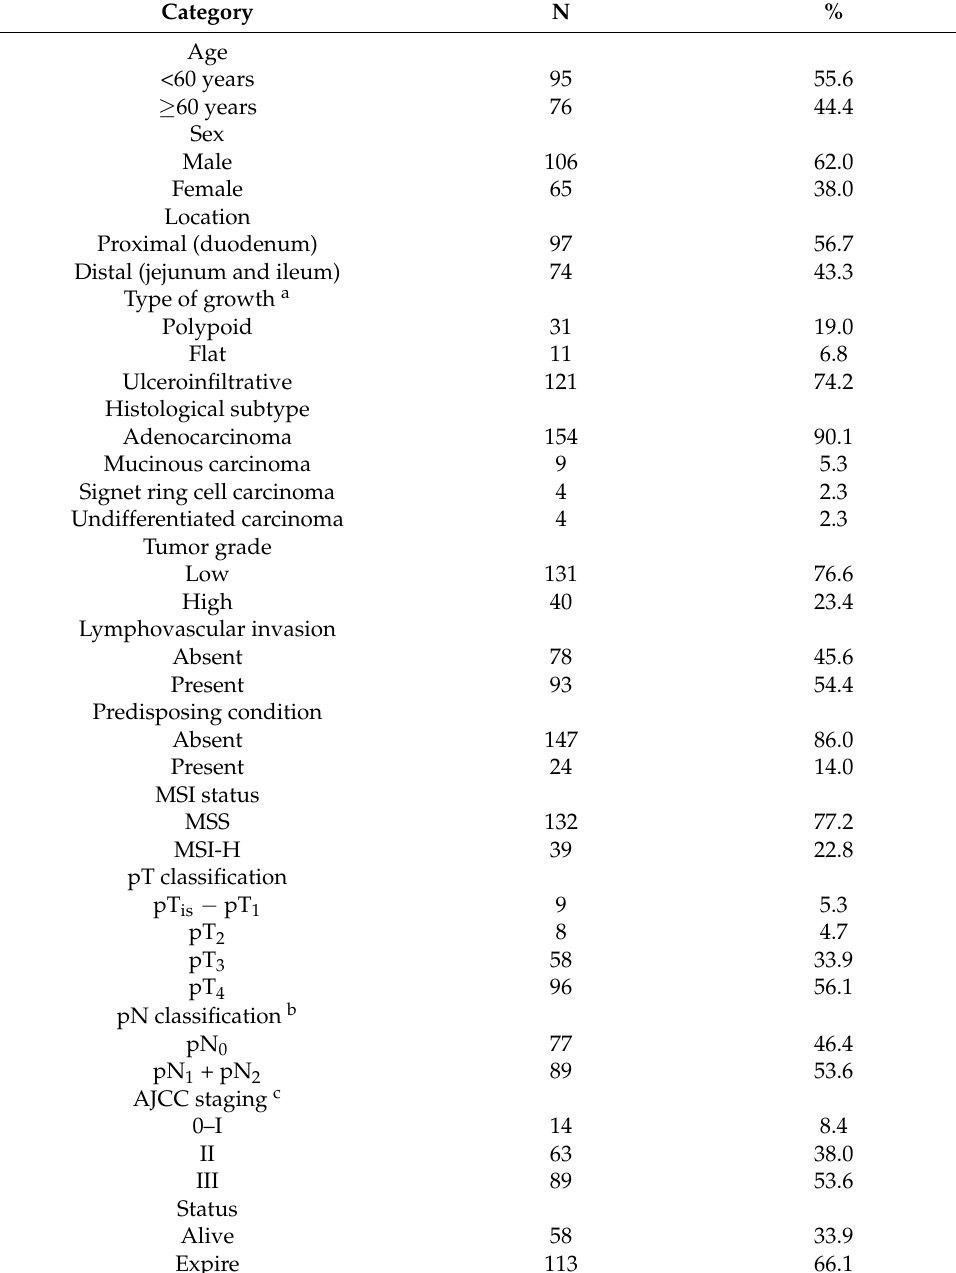
Table 1. Clinicopathologic characteristics of 171 patients with